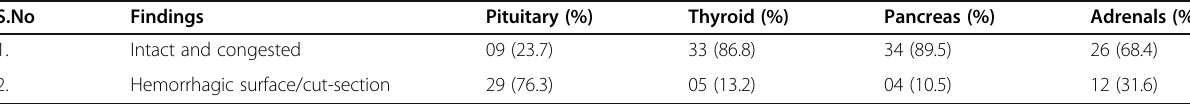
Table 2 Gross findings in endocrine glands